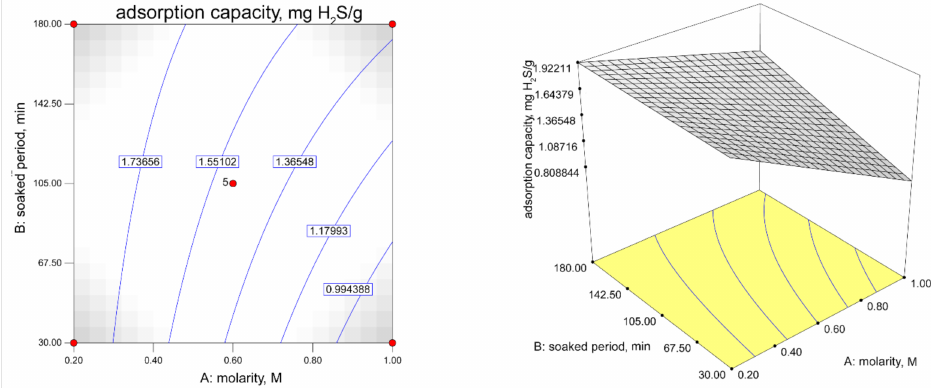
Figure 5. Contour plot describing the adsorption capacity response in soaked temperature function of ZnAc 2 molarity and soaked period (Soaked temperature: 65 ◦ C).